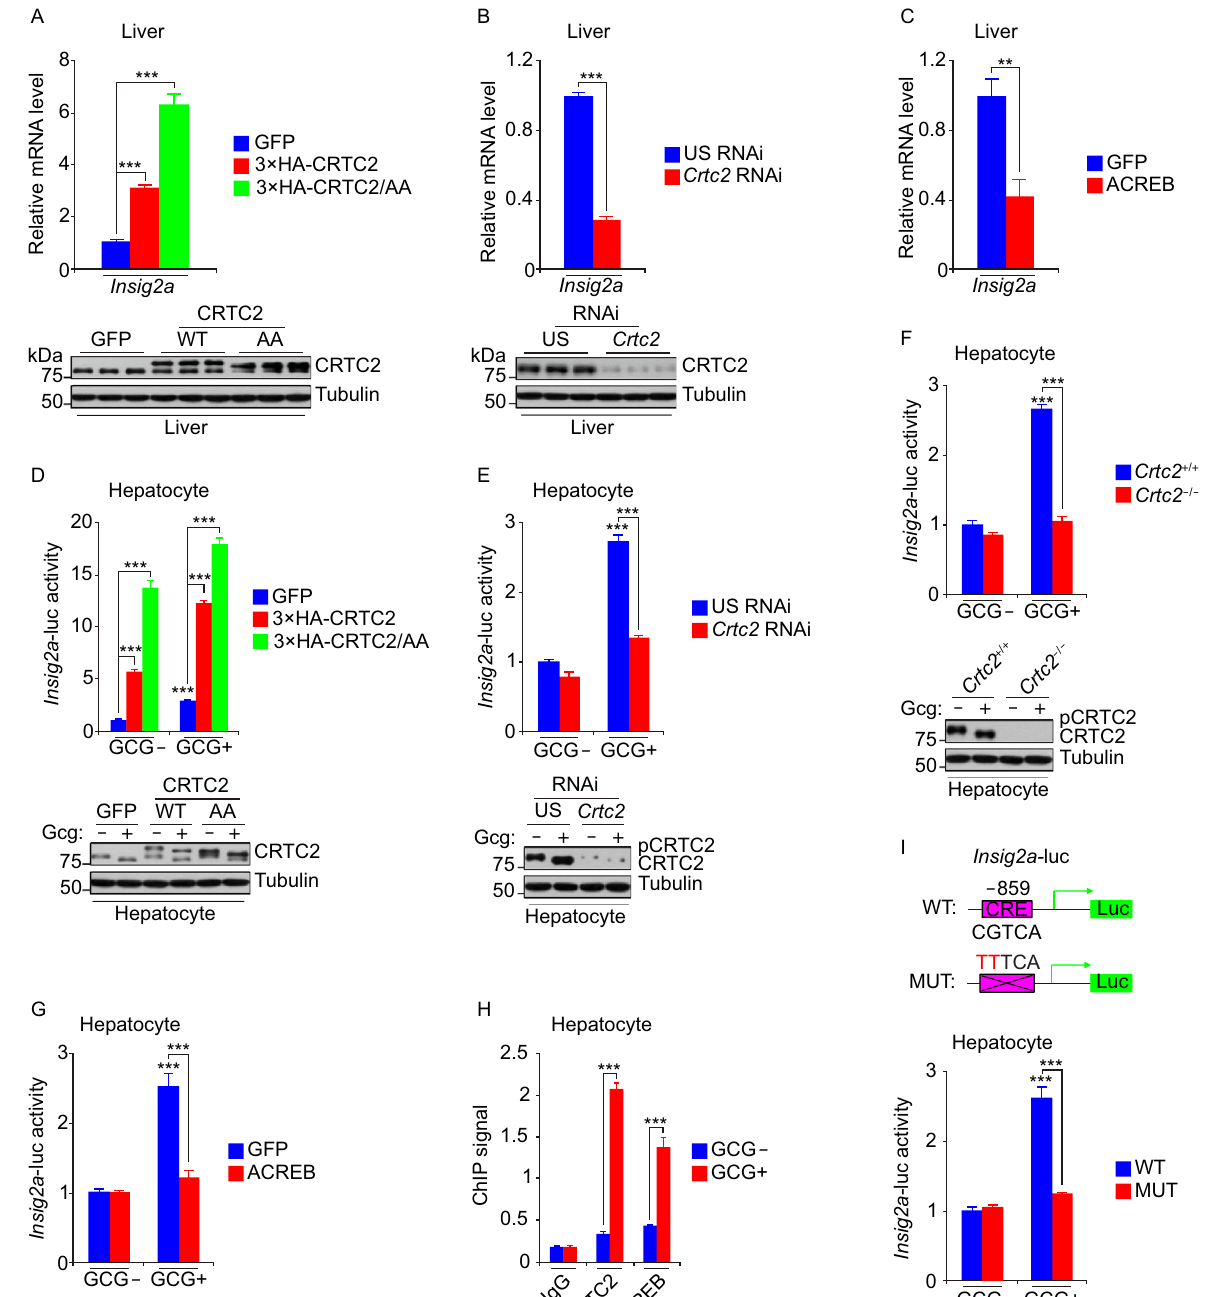
Figure 2. Insig2a is transcriptionally regulated by the CRTC2/CREB complex . (A – C) Effect of wild-type (WT) 3×HA-CRTC2 and its nuclear-localized mutant (FLAG-CRTC2/AA, CRTC2 with double Ala mutations at Ser171 and Ser275) (A), Crtc2 knockdown (B) or ACREB (C) on Insig2a expression in 12 h fasted mice. Bottom panels: Immunoblots showing the relative CRTC2 level. (D – G), Effect of 3×HA-CRTC2 and 3×HA-CRTC2/AA (D), CRTC2 de fi ciency by knockdown (E) or knockout (F), and ACREB (G) on Insig2a - luc activity in mouse primary hepatocytes. Bottom panels: Immunoblots showing the relative CRTC2 level. (H) Chromatin immunoprecipitation showing the occupancy of CRTC2 and CREB on the Insig2a promoter. (I) Top panel: Location of the wild-type (WT) CRE half-site and its mutant (MUT) within the mouse Insig2a promoter. Bottom panel: Relative luciferase activity with the wild- type or mutant Insig2a promoters in the presence or absence of glucagon. GCG, glucagon. US, unspeci fi c. Data are shown as mean ± s.e.m. **P < 0.01, ***P < 0.001, n =